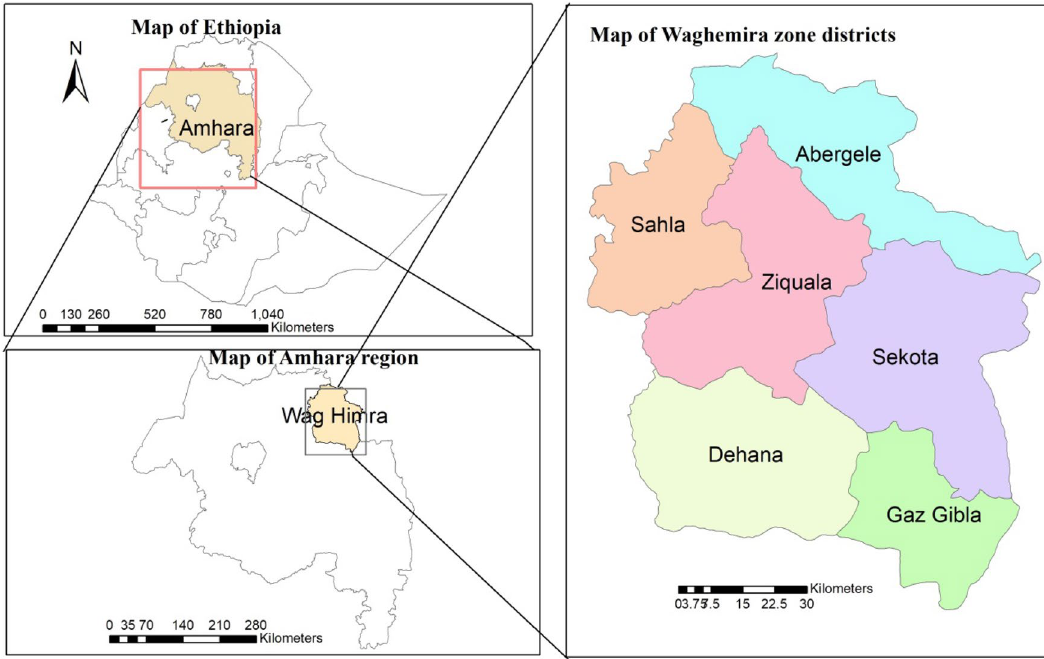
Figure 1. Map of the study area. The above maps were generated by ourselves using the ArcGIS version 10.8 software. The shape files of Ethiopia’s administrative regions, zones, and woredas were freely downloaded from a link https:// afric aopen data. org/ datas et/ ethio pia- shape